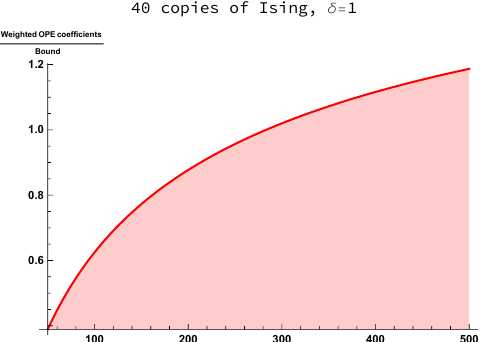
Figure 11 . Ratio of the weighted three point coe(cid:14)cients and the bound for 40 copies of Ising model with c e(cid:11) = 20, verifying the lower bound since the curve eventually goes above 1. Here we (cid:0) (cid:1) (cid:0) have O (cid:17) (cid:10) 12 (cid:15) (cid:10) 28 I